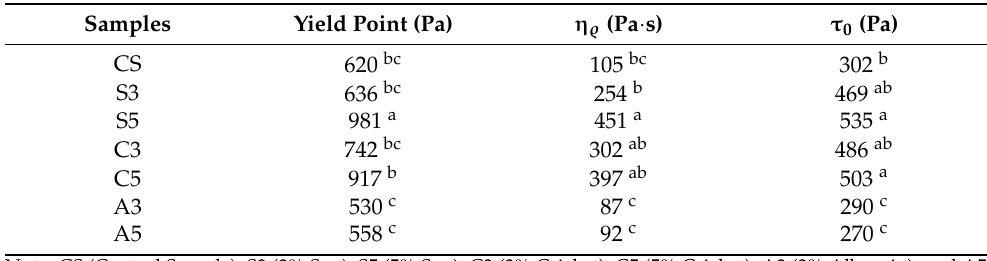
Table 3. The Bingham model η =η ᵨ + τ₀/ ɣ̇ parameters for the different proteins at different concen- trations.